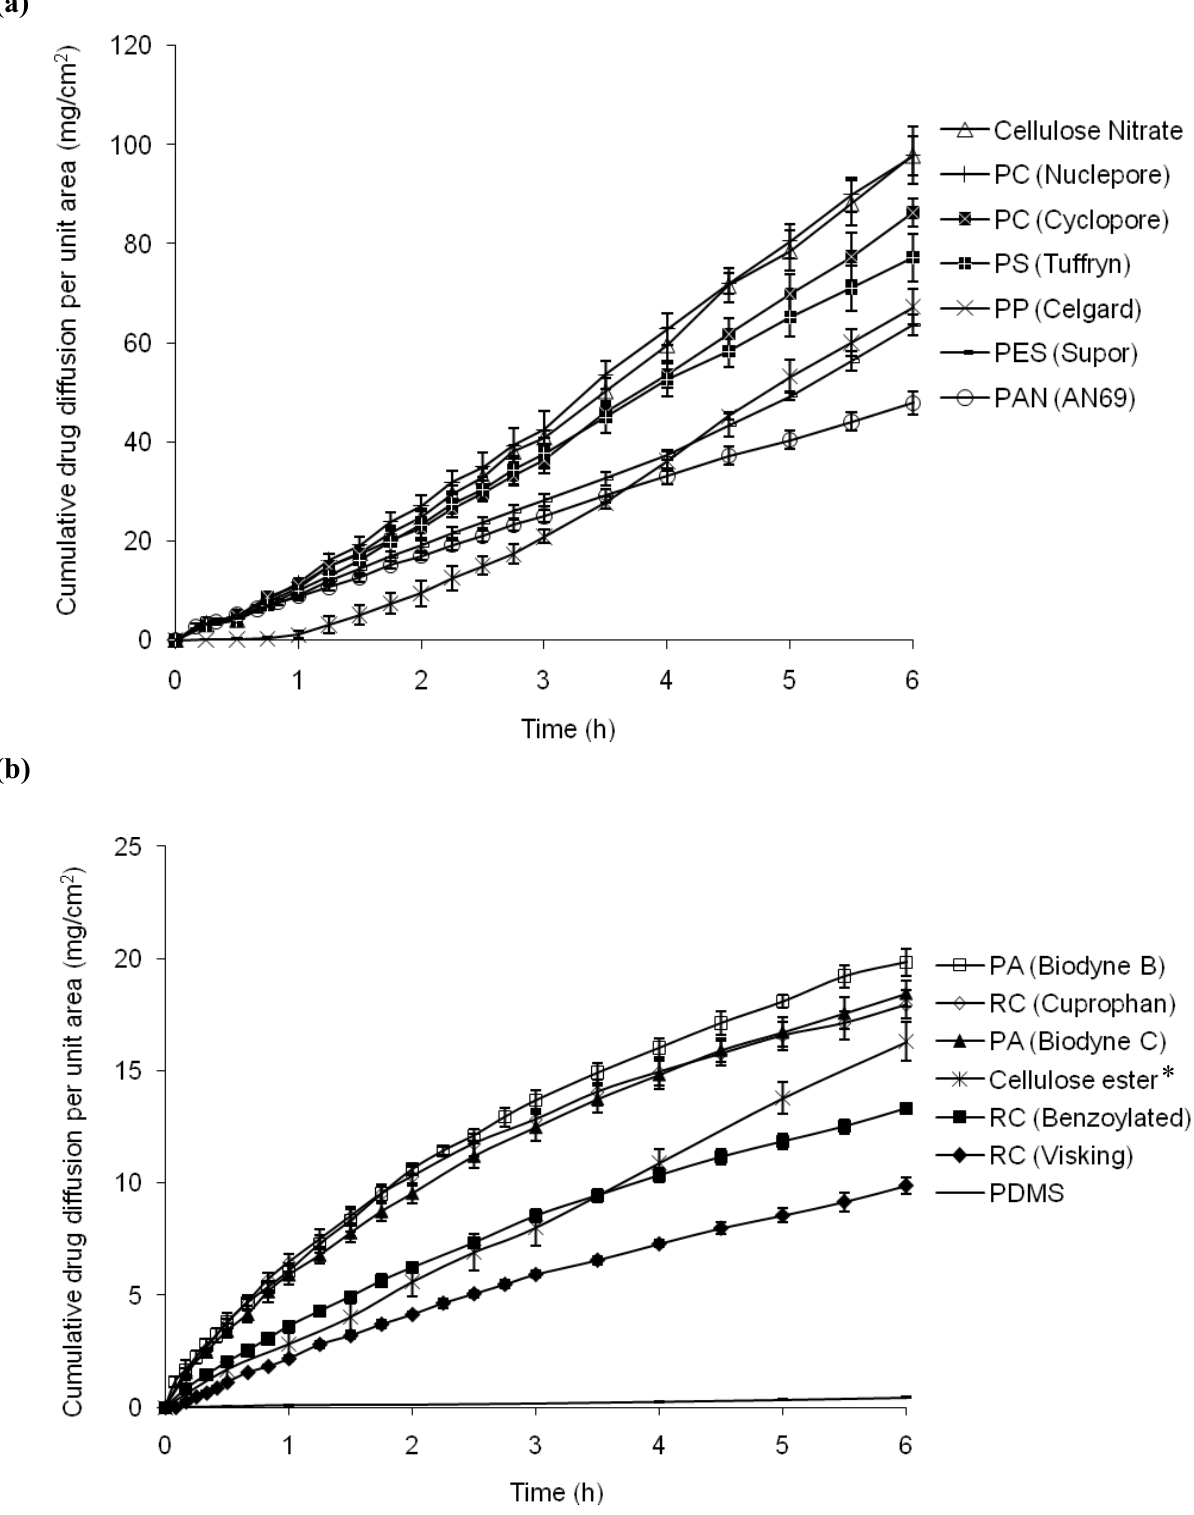
Figure 1. Plots of the cumulative ibuprofen diffusion per unit area over 6 h: (a) high flux membranes (b) low-flux membranes. *membrane may be unstable in the